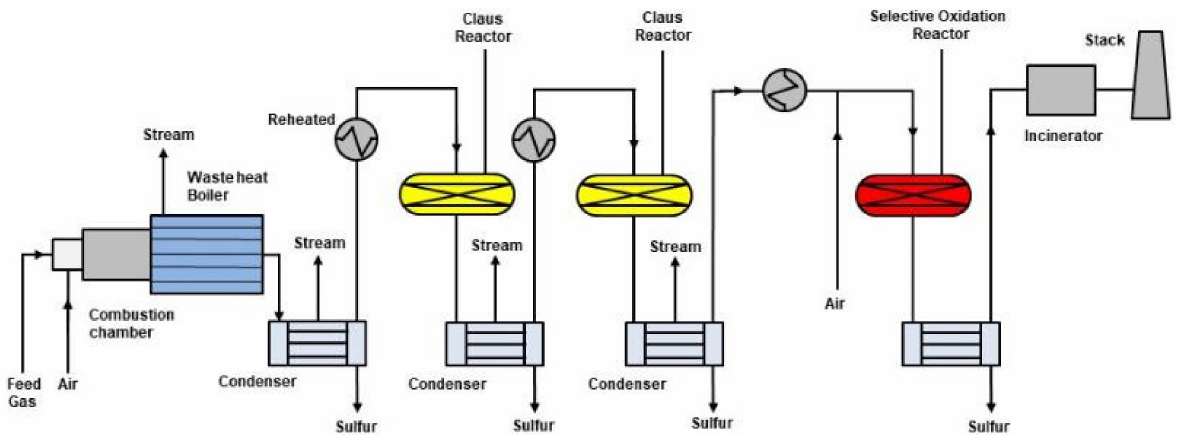
Figure 4. SuperClaus ® process flow sheet diagram (adapted from